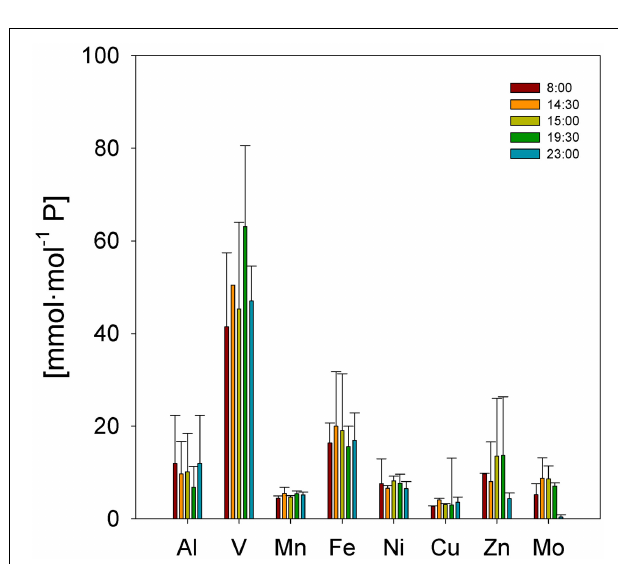
FIGURE 7 |Temporal comparison of P-normalized element quotas determined by ICP-MS for natural Trichodesmium populations. Bars are means ±